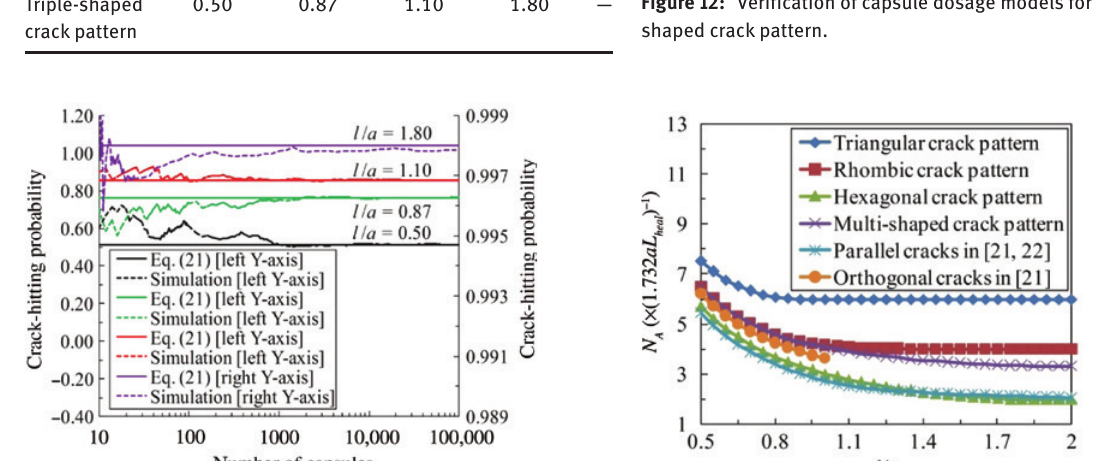
Figure 12: Verification of capsule dosage models for the multi- shaped crack pattern.